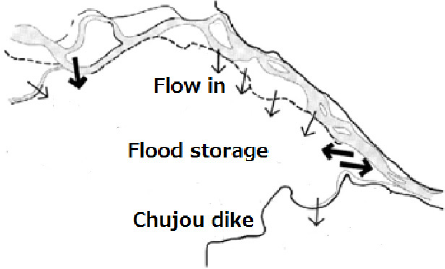
Figure 4. Levee constructed for flood storage in the middle reaches of the Tone River in the Edo